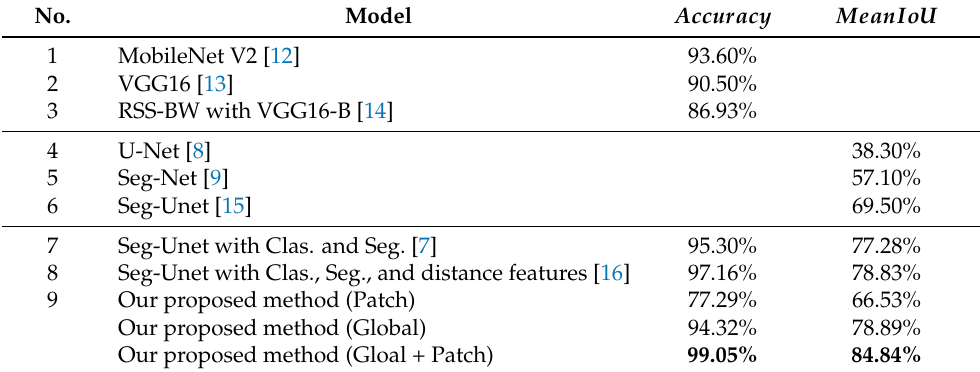
Table 5. Performance comparison with related studies on the CNUH validation